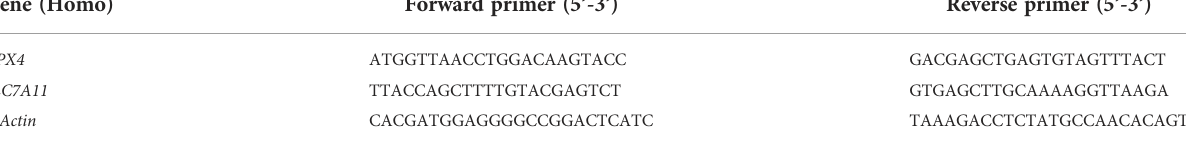
TABLE 1 Primer sets used for